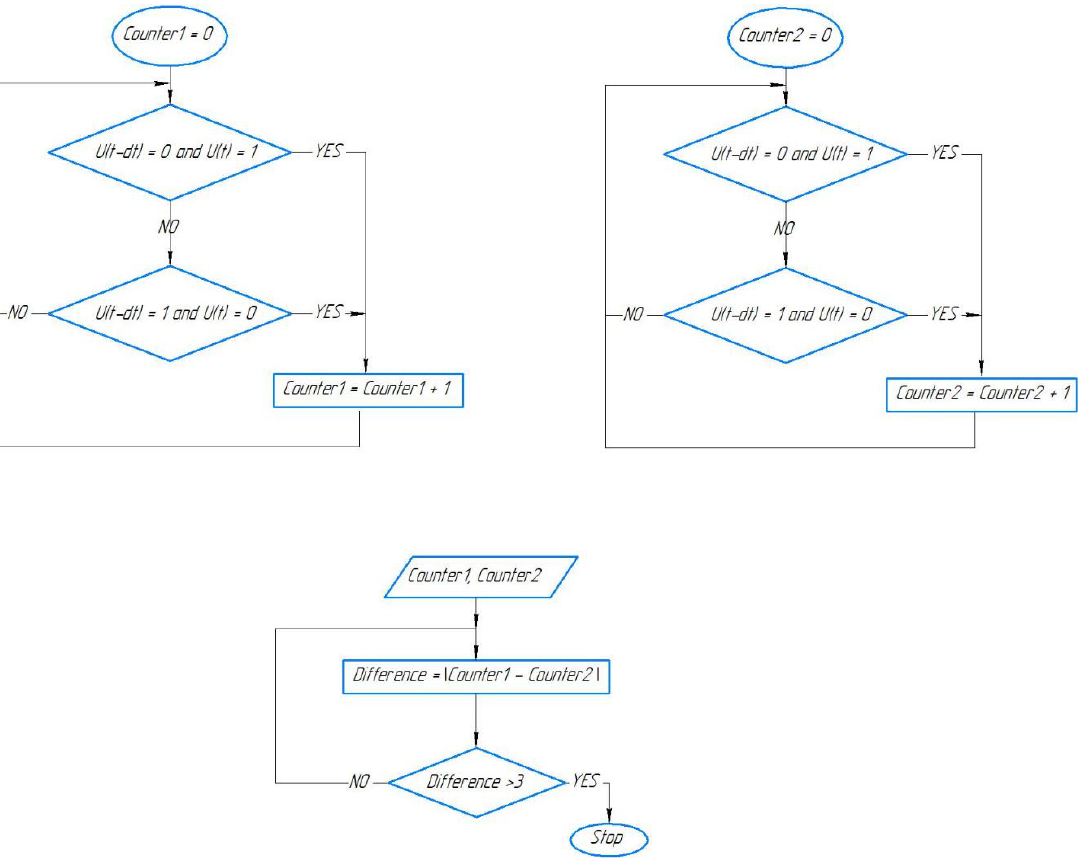
Figure 3. Block diagram of the algorithm with a counter.